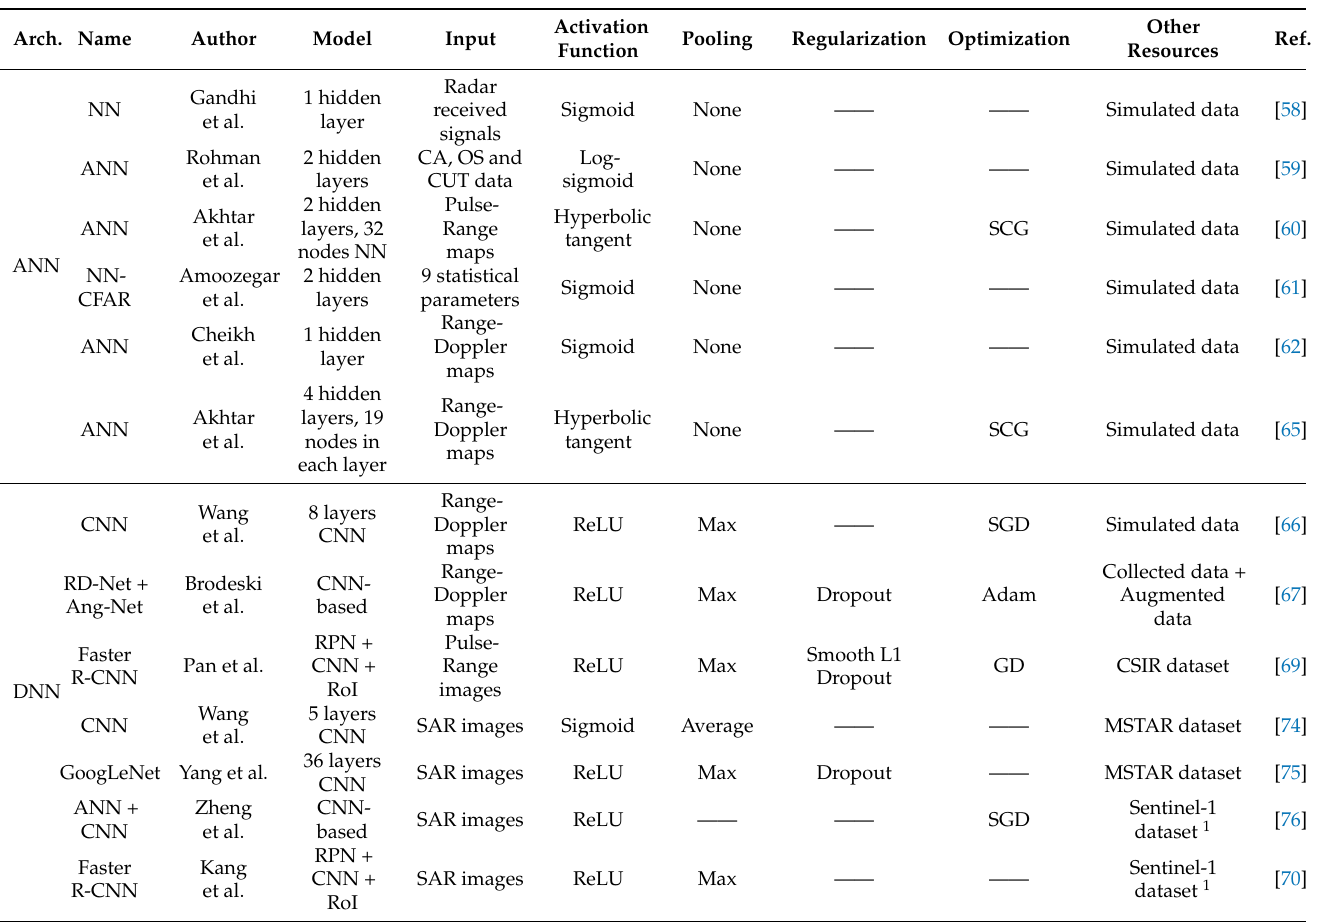
Table 2. Summary of RTD models in the